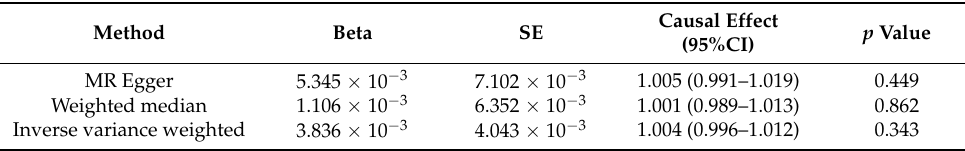
Table 5. Sensitivity analysis 5. Mendelian randomization analysis for the causal effect between depression and colorectal